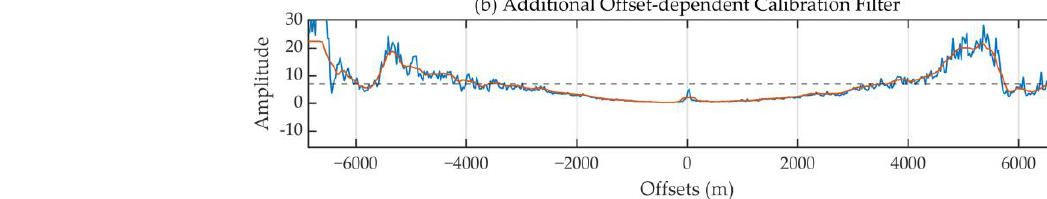
Figure 11. 2D phase spectrum of composite P / v x calibration filter.